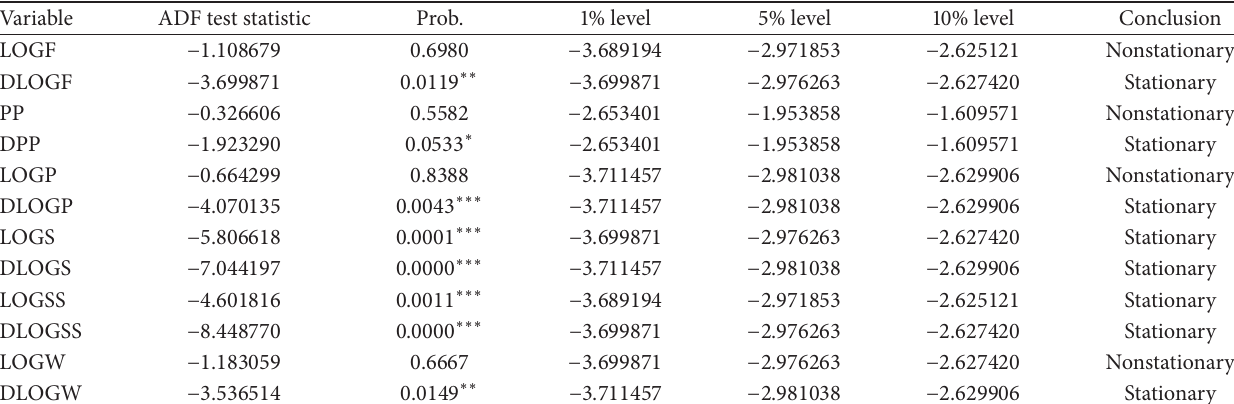
Table 1: ADF unit root test